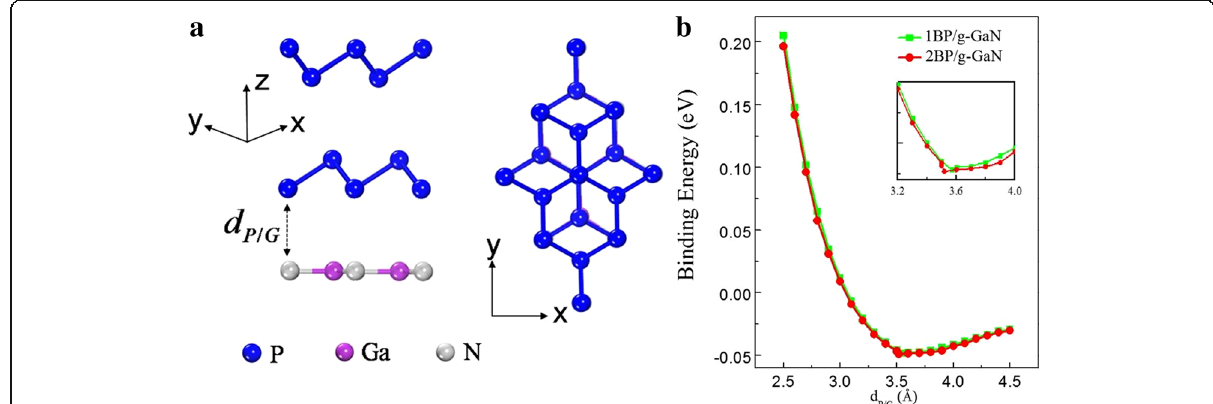
Fig. 1 a Side and top view of bilayer blue-P on g-GaN. b Binding energy as a function of the distance d blue-P/g-GaN for the monolayer and bilayer system. The inset shows the zoom close the minimum of the binding energy